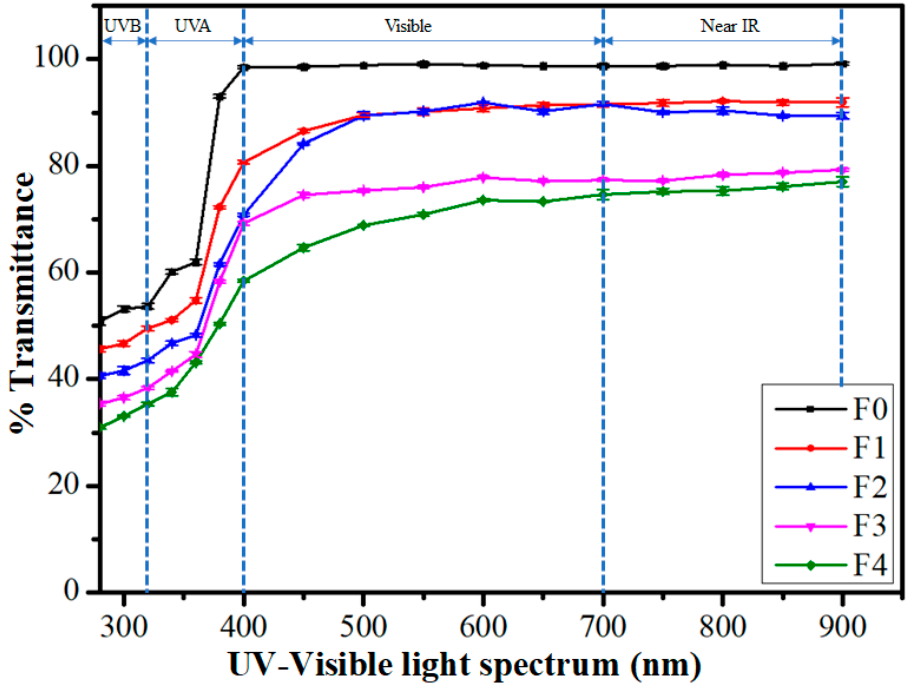
Figure 6. Transmittance spectra of the composite films.